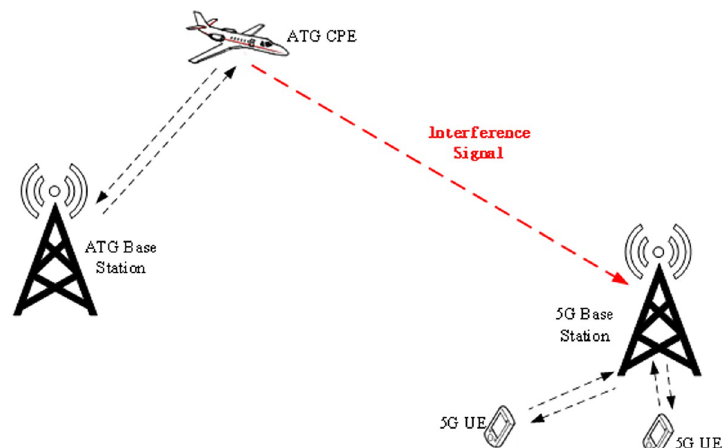
Fig. 2 Earth-space clutter loss between ATG and other